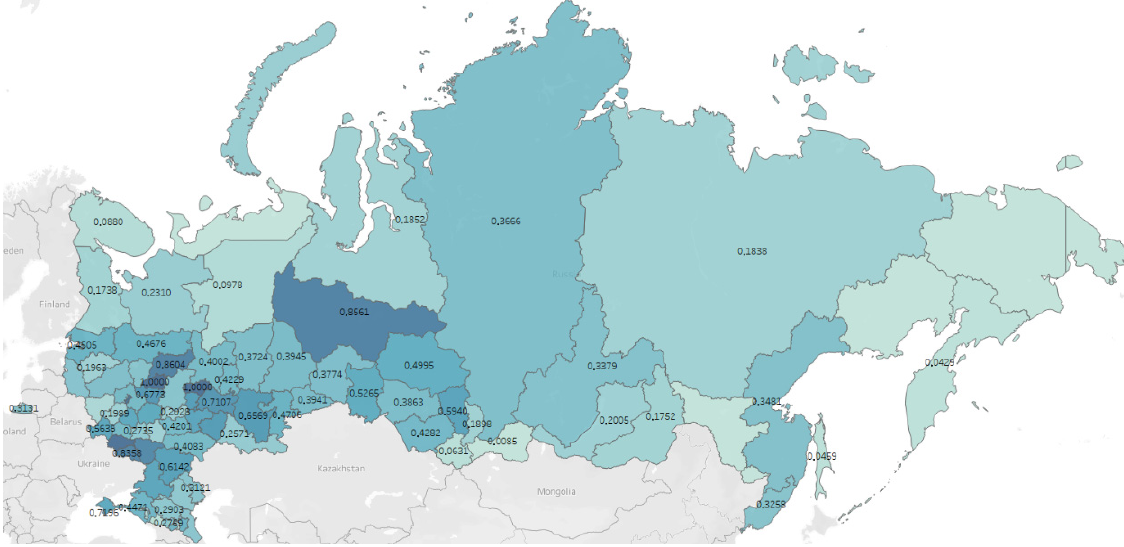
Figure 2. Map of the performance rating of RISs for 2016 (the first stage of the analysis). This map makes it possible to see regions with the highest level of RIS efficiency related to patent activity. They are the Ivanovo Region (1), Kursk Region (1), the Republic of Mari El (1), Kostroma Region (0.8604), Khanty-Mansi Autonomous Okrug (0.8561), Belgorod Region (0.8358) and Voronezh Region (0.8109). Next, we analysed the performance rating map of RISs for 2019 (the last period of the